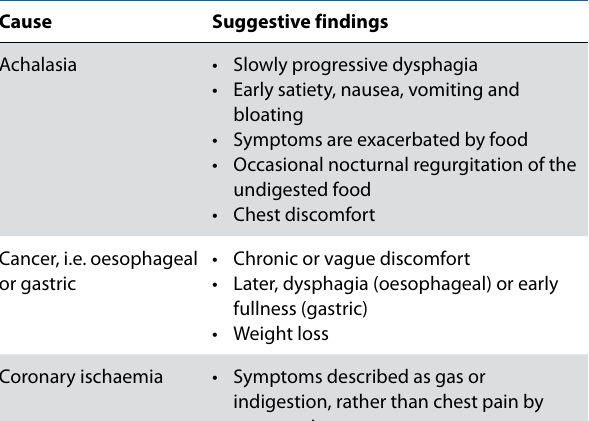
Table 3: Common causes of dyspepsia and their suggestive findings